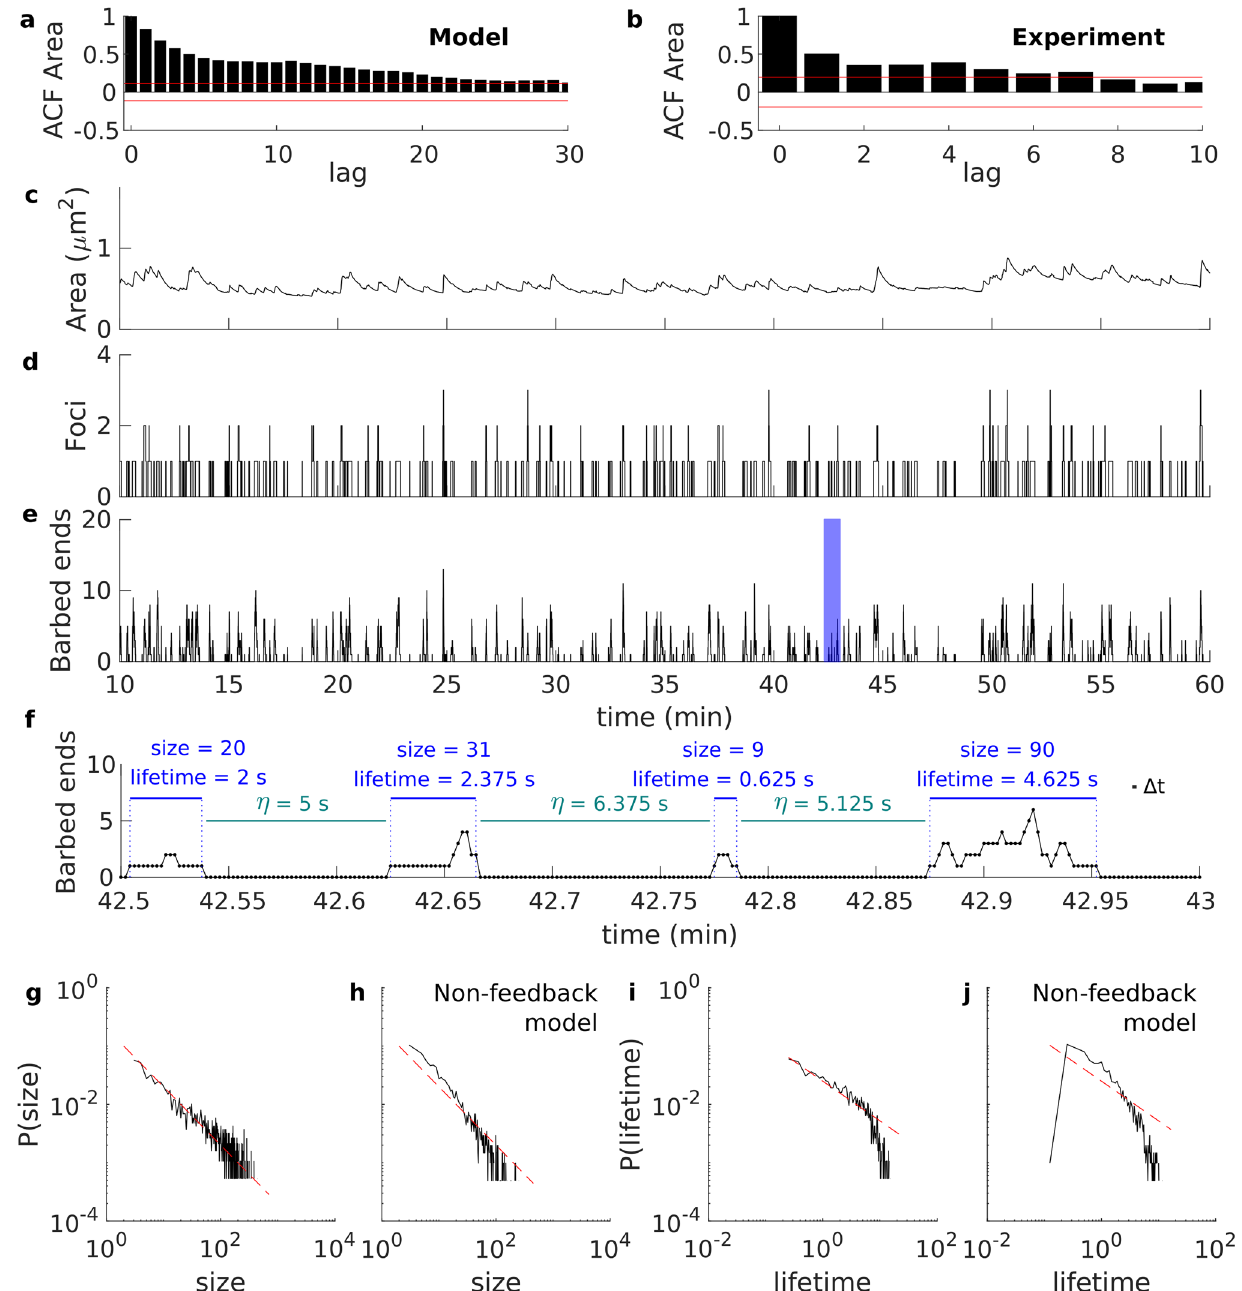
Figure 7. Actin in spines self-organizes into a critical state. ( a ) First lags (10%) of the autocorrelation function of the sampled area from Fig. 5b. Dashed red lines correspond to the 95% confidence bands. ( b ) Same as ( a ) but calculated from the experimental data in Fig. 4a. Spine area ( c ), number of actin polymerization foci ( d ), and total number of barbed ends in the spine ( e ) corresponding to the simulation in Fig. 5. ( f ) Zoom of the blue- shaded interval in ( e ). Each dot indicates the number of barbed ends at each time-step. The size and duration of the avalanches of actin polymerization, as well as the interval between avalanches ( η ), is displayed. Log–log plot of the probability of avalanche size ( g ), and lifetime ( i ) corresponding to the data from 10 simulations of the model. Red dotted lines correspond to straight lines with slope of − 1 ( g ) and − 0.68 ( i ), plotted for visualization purposes. ( h , j ) Same as in ( g ) and ( i ) but using the simulations of the model without feedback in the branching